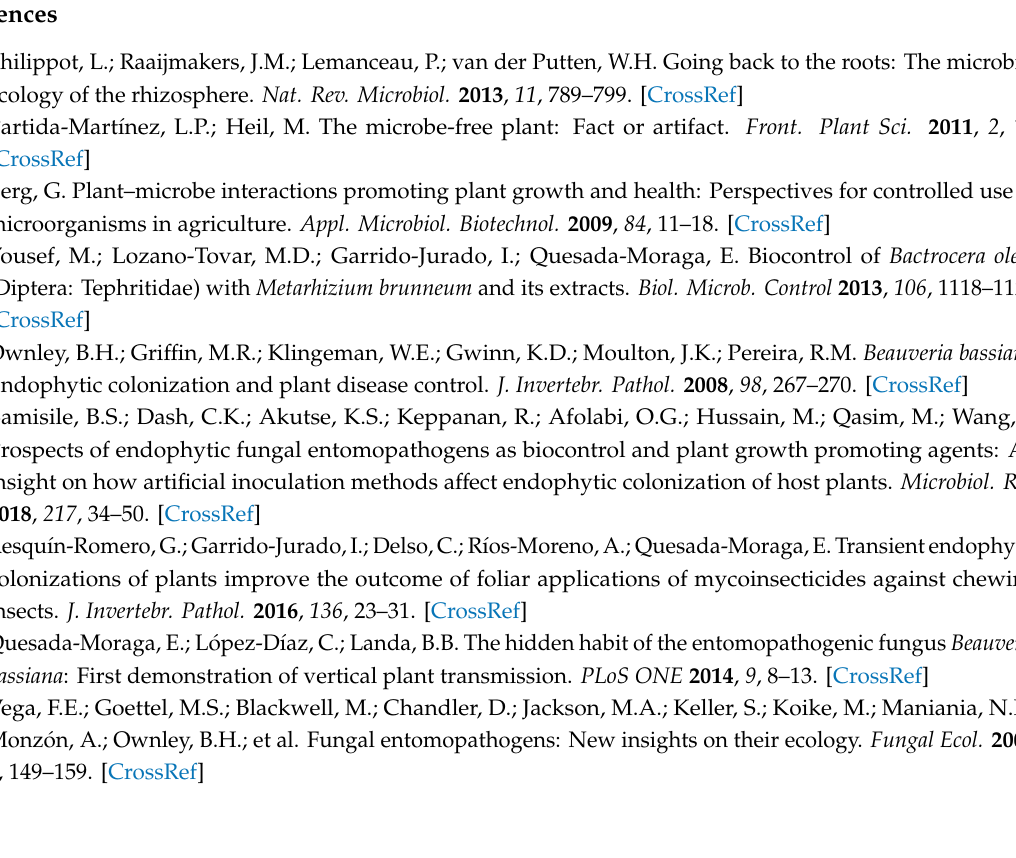
and after ( y -axis) cropping, Table S1: Additional soil properties ‡ of the soils described in Sacrist á n et al. (2019) [24], Table S2: One-way ANOVA or Kruskal–Wallis test and comparison of means ‡ for wheat biomass, nutrient uptake and grain nutrient concentration (mean value, n = 18) on the di ff erent soils at harvest, Table S3: Factorial ANOVA (soil × fungal treatment) and Kruskall–Wallis test ( † , when data failed to fulfill the criteria for parametric analysis) for grain yield, straw and nutrient uptake of durum wheat plants grown on GSGYI < 15. § Significant di ff erences ( p < 0.05) are in boldface. Table S4: Factorial ANOVAs for nutrient uptake and grain nutrient concentration (mean ± standard error) with soil and fungal treatment as factors for the GSGYI > 15. Significant di ff erences ( p < 0.05) are in boldface, Table S5: Factorial ANOVA (soil × fungus) and Kruskall–Wallis test ( † , when data failed to fulfill the ANOVA criteria) for grain nutrient concentration in the GSGYI < 15. § Significant di ff erences ( p < 0.05) are in boldface, Table S6: Paired t-test for nutrient uptake (mean ± SE) of fungus-treated plants against non-inoculated plants ( n = 72) at harvest (102 DAS). Significant p values ( p < 0.05) are in boldface, Table S7: Paired t-test for grain nutrient concentration (mean ± SE) of fungus-treated plants against non-inoculated plants ( n = 72) at harvest (102 DAS). Significant p values ( p < 0.05) are in